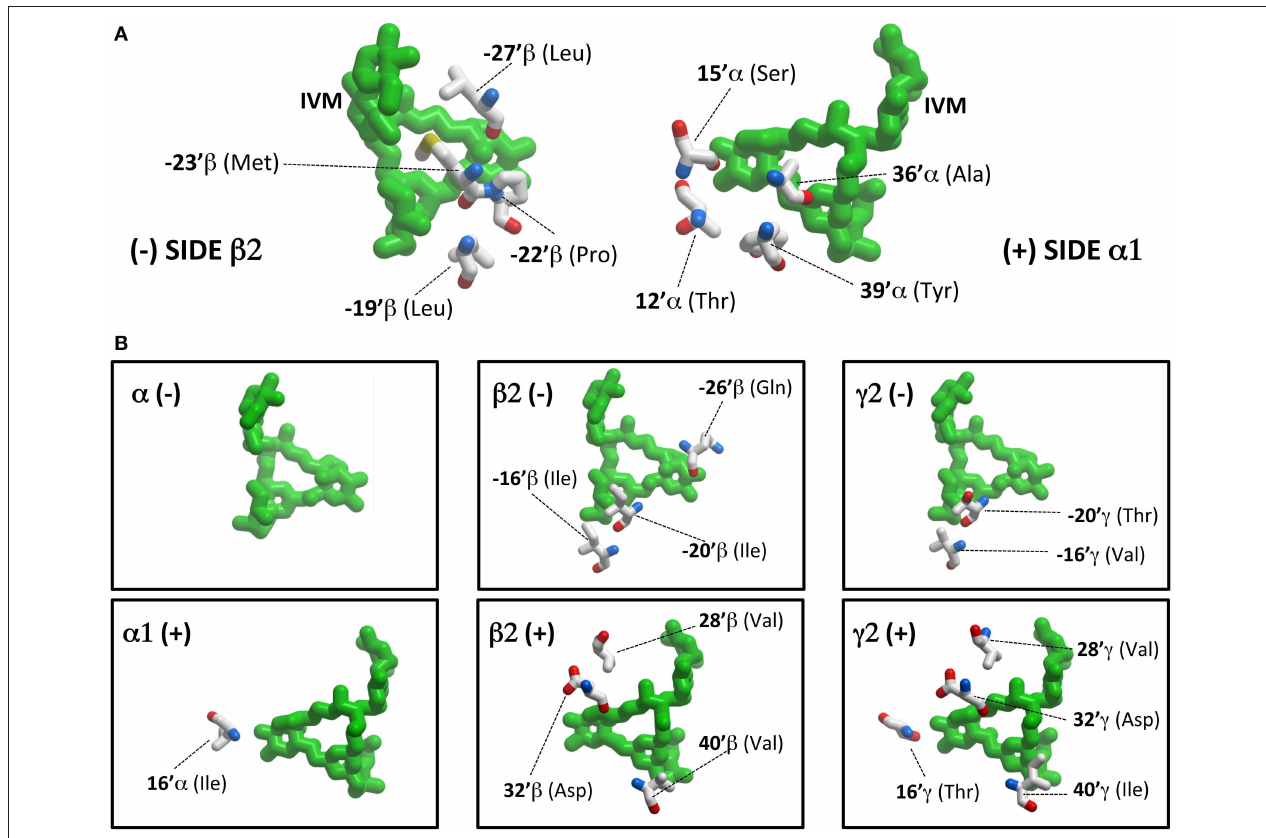
FIGURE 3 | Ivermectin contact residues. (A) This panel shows ivermectin bound at the α 1- β 2 interface, viewed from within the plane of the membrane from the ( − ) side of the interface (left panel) and the ( + ) side of the interface (right panel). Note it only displays interacting residues that are common to all four interface binding sites. (B) This panel shows additional interacting residues, relevant to particular interfaces only. For example, at the β 2 ( − ) interface, ivermectin interacts with a total of 7 residues (4 depicted in A and 3 depicted in B ).